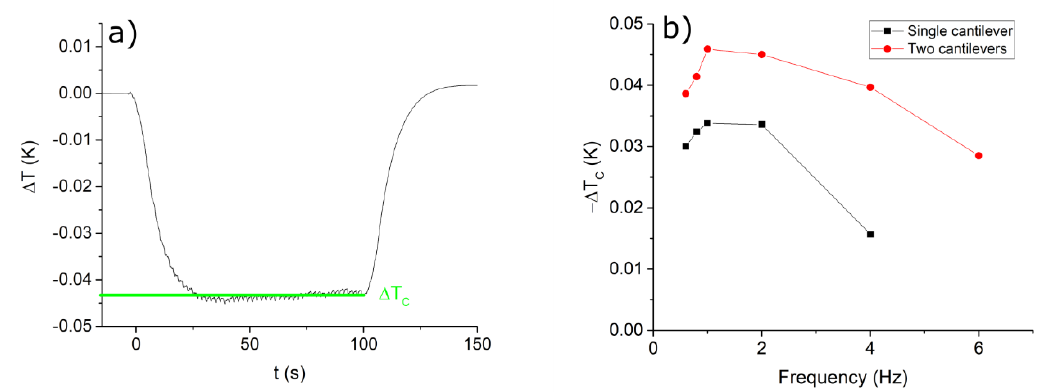
Figure 7. Performance of the proof-of-concept device. ( a ) Time evolution of the temperature of the heat source (represented by the Pt1000 temperature sensor) during cycling with 45 kV/cm and 2 Hz. The case is for two cantilevers being active. The green line denotes the equilibrated temperature drop — Δ T C . ( b ) Δ T C obtained at different frequencies with one active cantilever (black curve) and two active cantilevers (red curve) in the cascade.